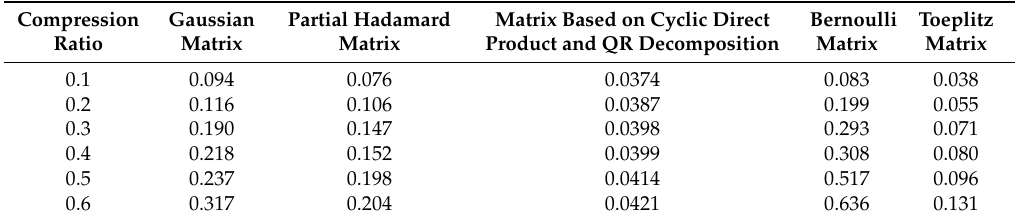
Table 1. Construction time for various types of measurement matrix at different compression ratios